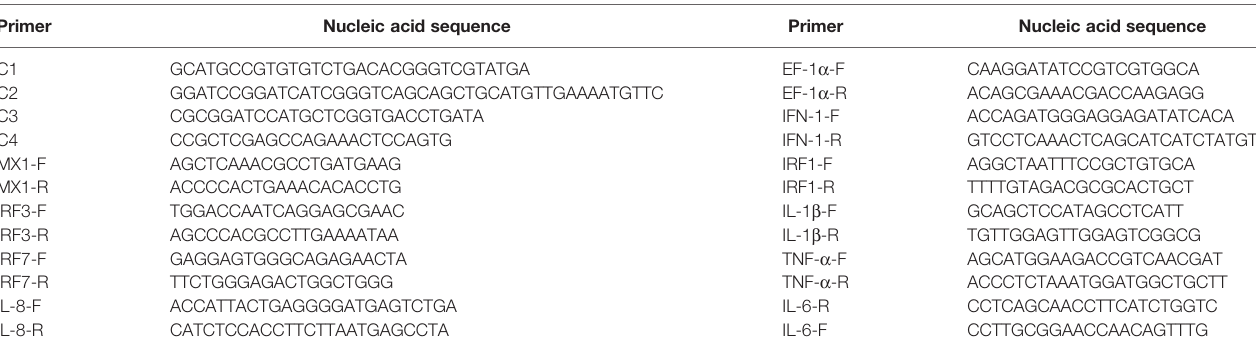
TABLE 2 | Primers for PCR and